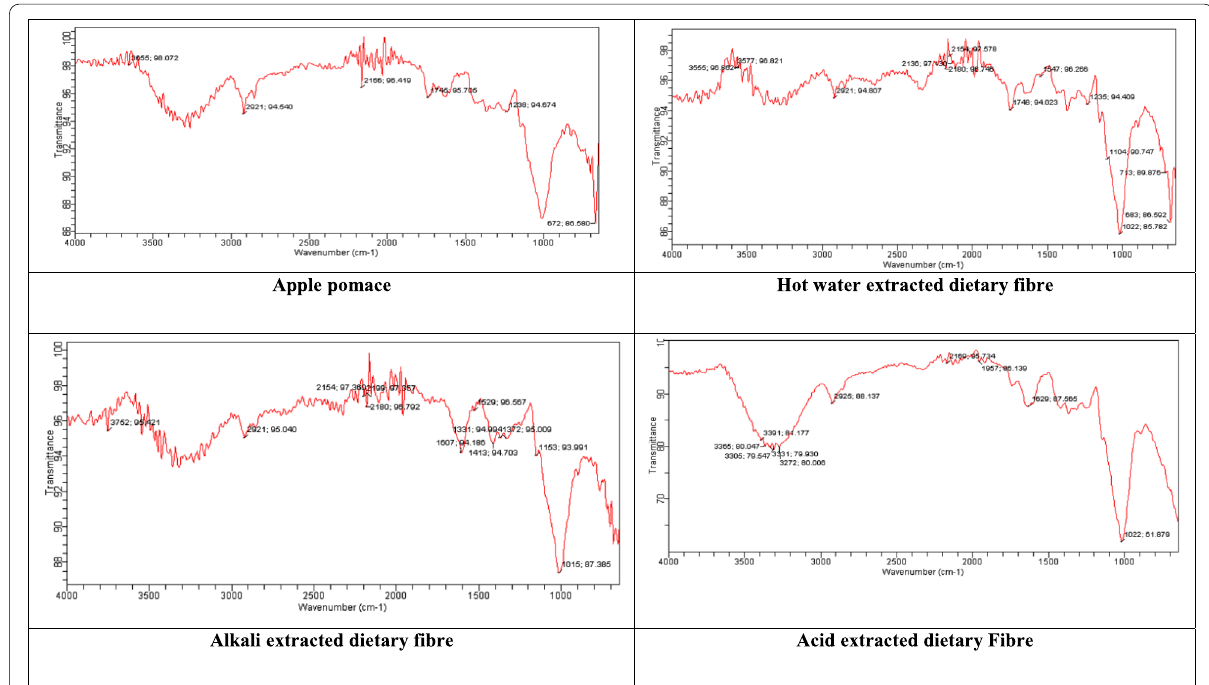
Fig. 2 FT-IR transmittance value for IR wavenumber from 650 to 4000 cm-1 for apple pomace and extracted dietary fiber